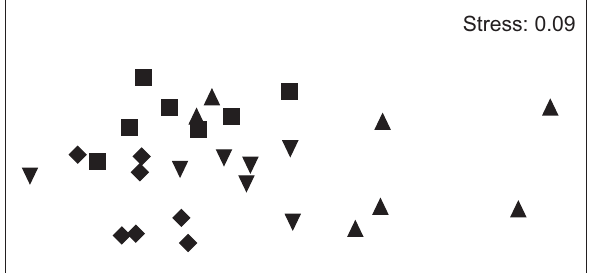
Figure 8. Multidimensional scaling plot of the copepod assem- blage structure (ind.m -3 ) found during the 2-year sampling period (2003-2004) in the Caravelas River estuary and the adjacent coastal region (Bahia, Brazil): black triangle 2003 Rainy season, black in- verted triangle 2003 Rainy season, black square 2004 Rainy sea- son, black diamond 2004 Dry